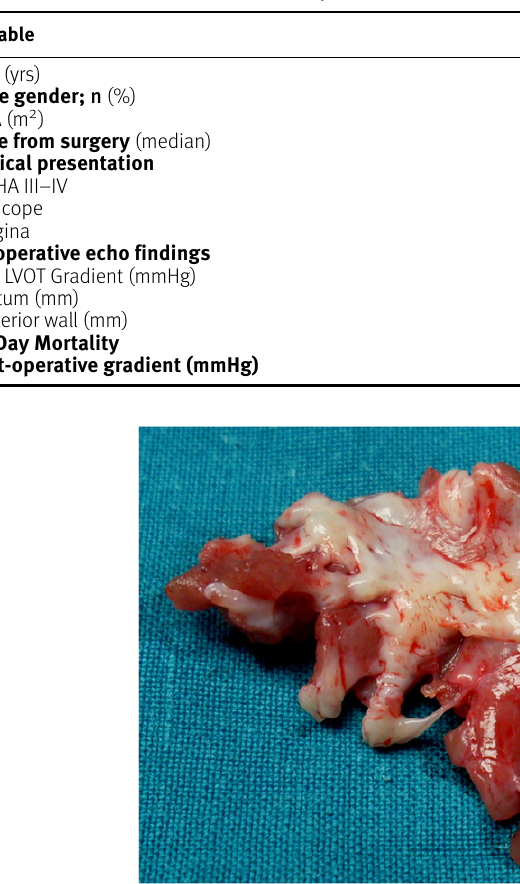
Table 1. Patient characteristics and operative outcomes.